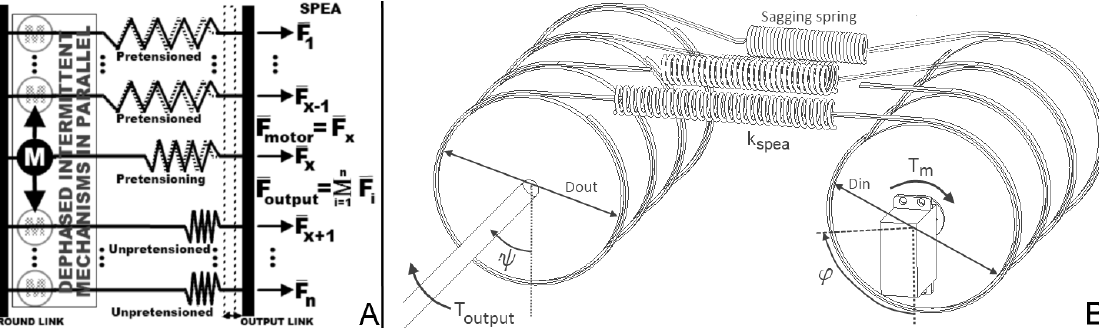
Figure 5. A general scheme of an series-parallel elastic actuation (SPEA) with dephased intermittent mechanisms in parallel in (A) and a scheme of the agonistic drum-drum SPEA with all the relevant parameters in (B). The agonistic drum-drum SPEA is based on the SEA set-up in Figure